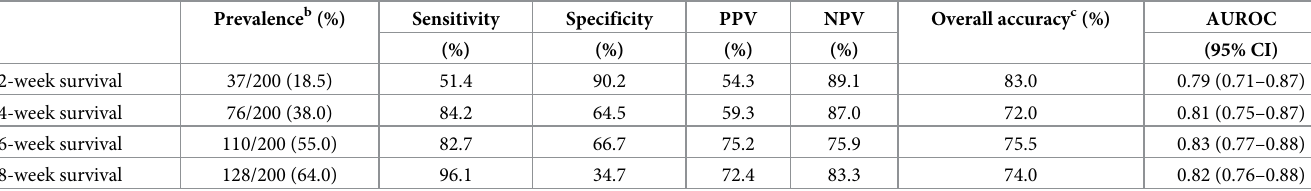
Table 3. Accuracy of clinician prediction of survival a .